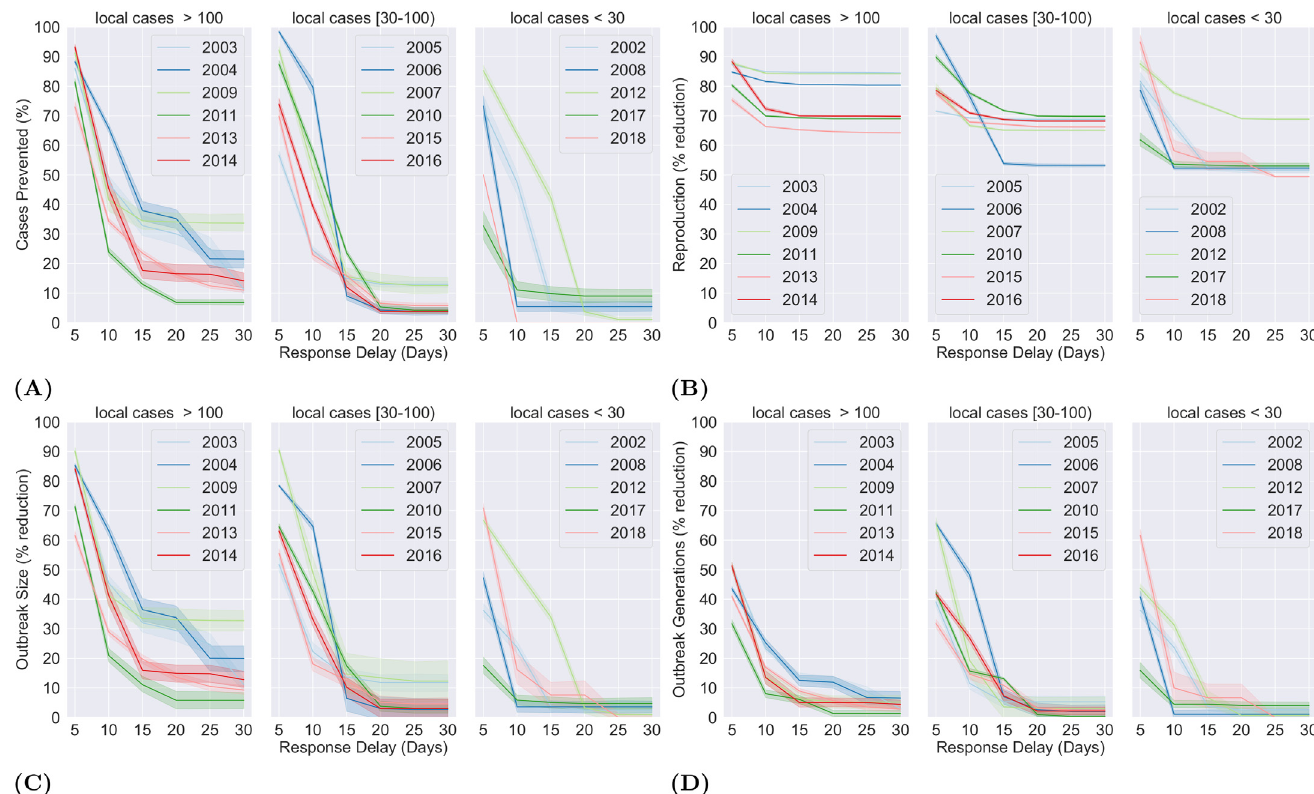
Fig 3. Temporal calibration of disease response. The impact of varying response delay thresholds on the dynamics of dengue occurrence. (A) plots percentage of cases prevented while (B), (C) and (D) plot percentage reduction in reproduction, outbreak size and number of generations against varying response delay thresholds. The reproduction denotes the number of secondary cases per fertile case, the size and generations of an outbreak denotes the number of cases and number of generations in the infection chain of the outbreak, respectively.